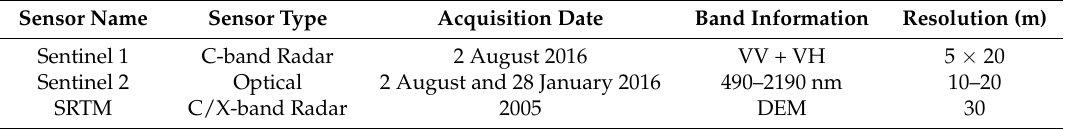
Table 1. Summary of the characteristics of the remotely sensed datasets used in this study.